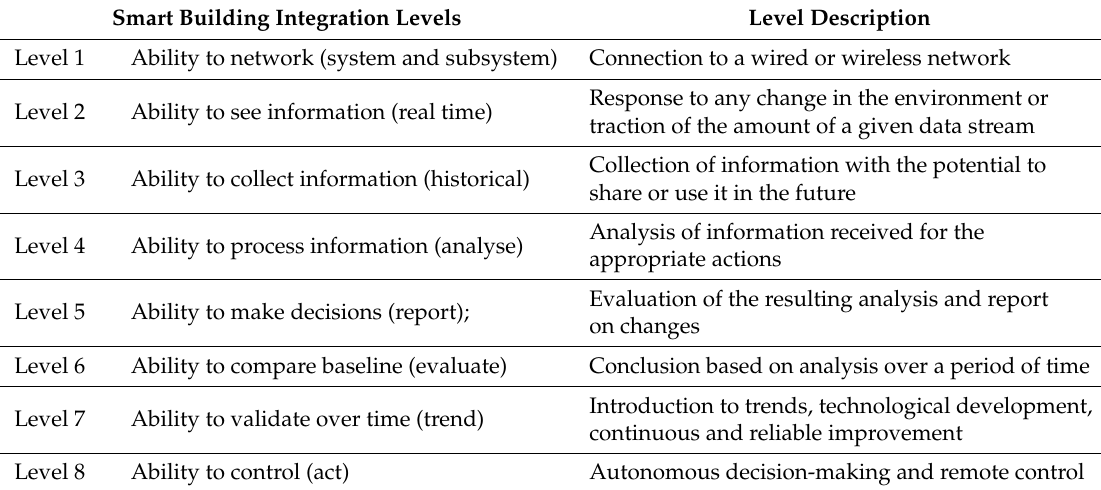
Table 7. Smart building integration levels into a smart city information and communication technology